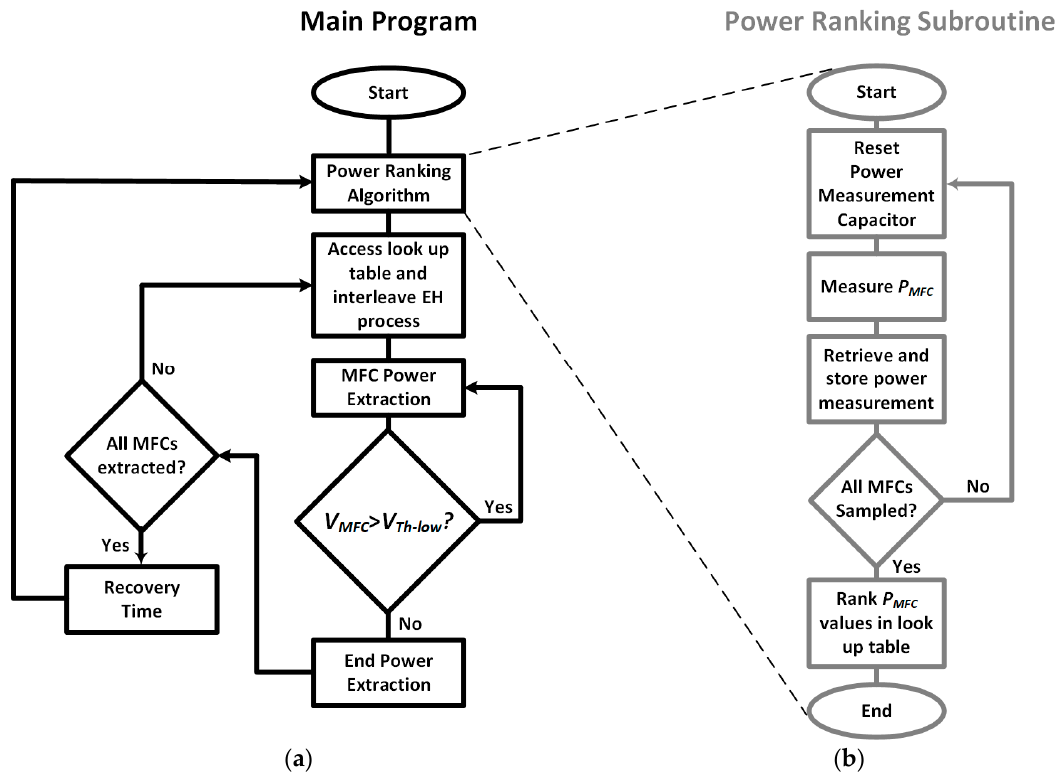
Figure 6. Flow diagram for MFC power extraction: ( a ) Main Program and ( b ) Power Ranking Algorithm subroutine.